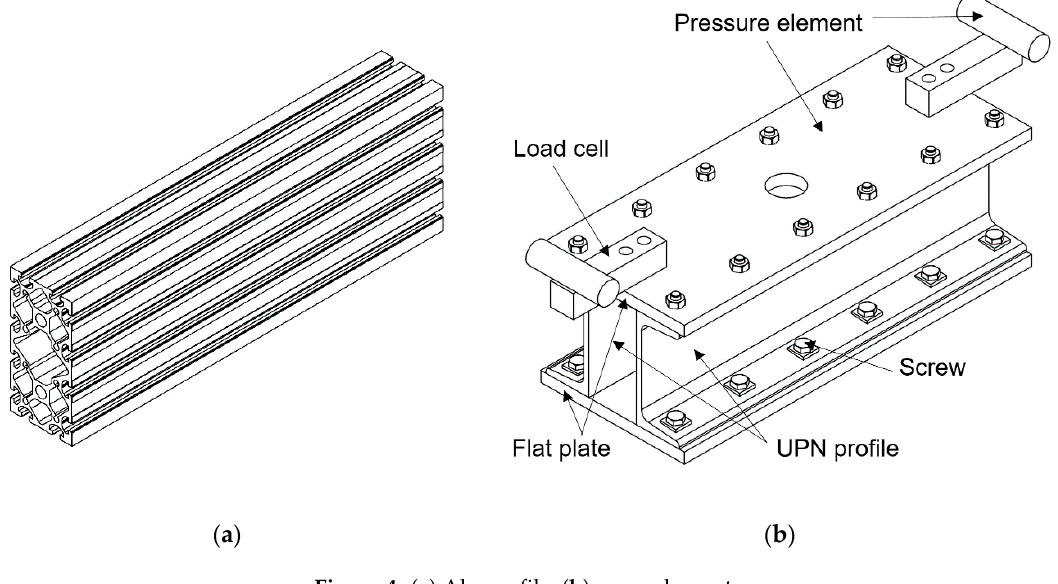
Figure 3. Components of the test rig: 1. Frame, 2. Frame connecting plate, 3. Support, 4. Specimen, 5. Load cell, 6. Pressure element, 7. Pressure element guide, 8. Pneumatic cylinder, 9. Displacement sensor.